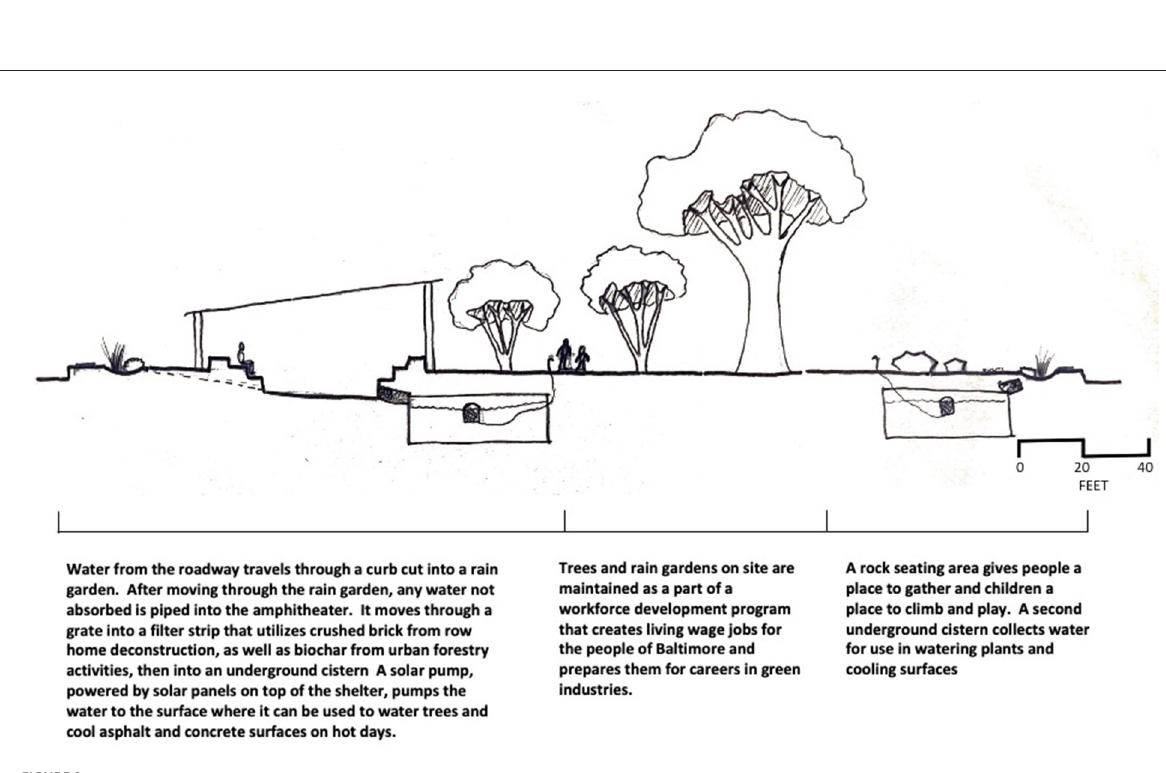
FIGURE9 Systems diagram of land reclamation as a regenerative, social-ecological